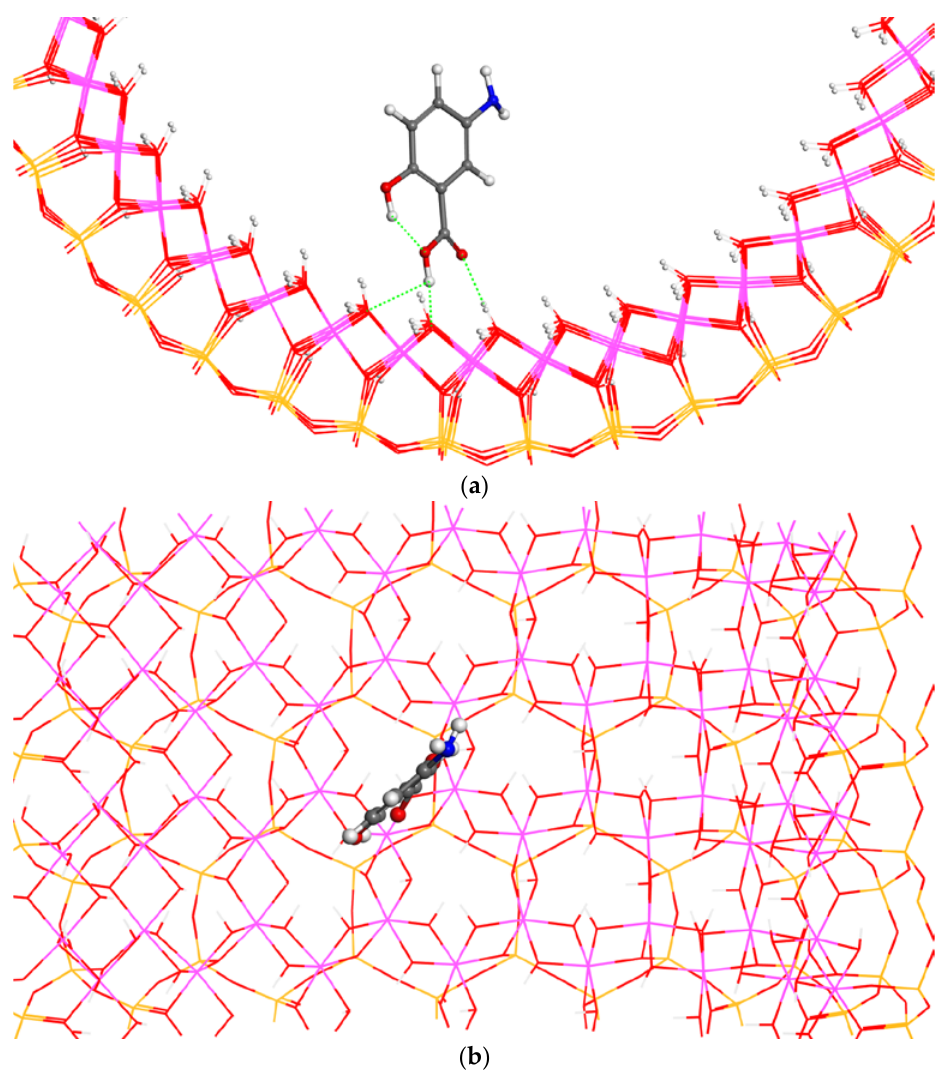
Figure 5. Adsorption of the conformer F1 of 5-ASA oriented perpendicularly with respect to the halloysite surface after its optimization. Views from the (001) ( a ) and (010) ( b ) crystallographic planes.